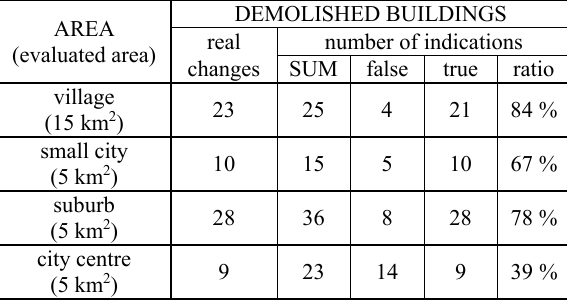
Table 18. Results of